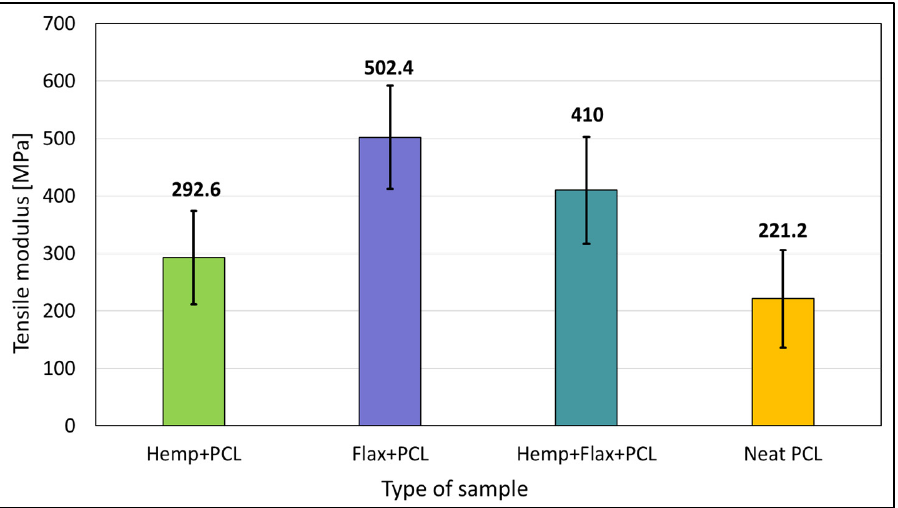
Figure 5. Tensile modulus comparison of different samples.